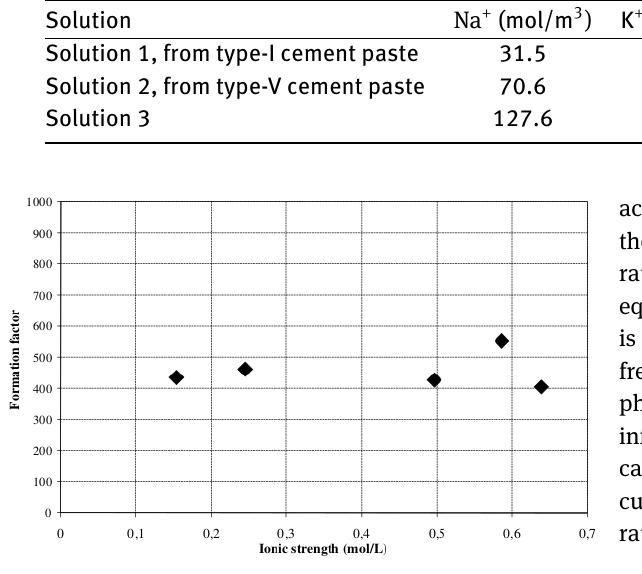
Figure 4: Formation factors as a function of the ionic